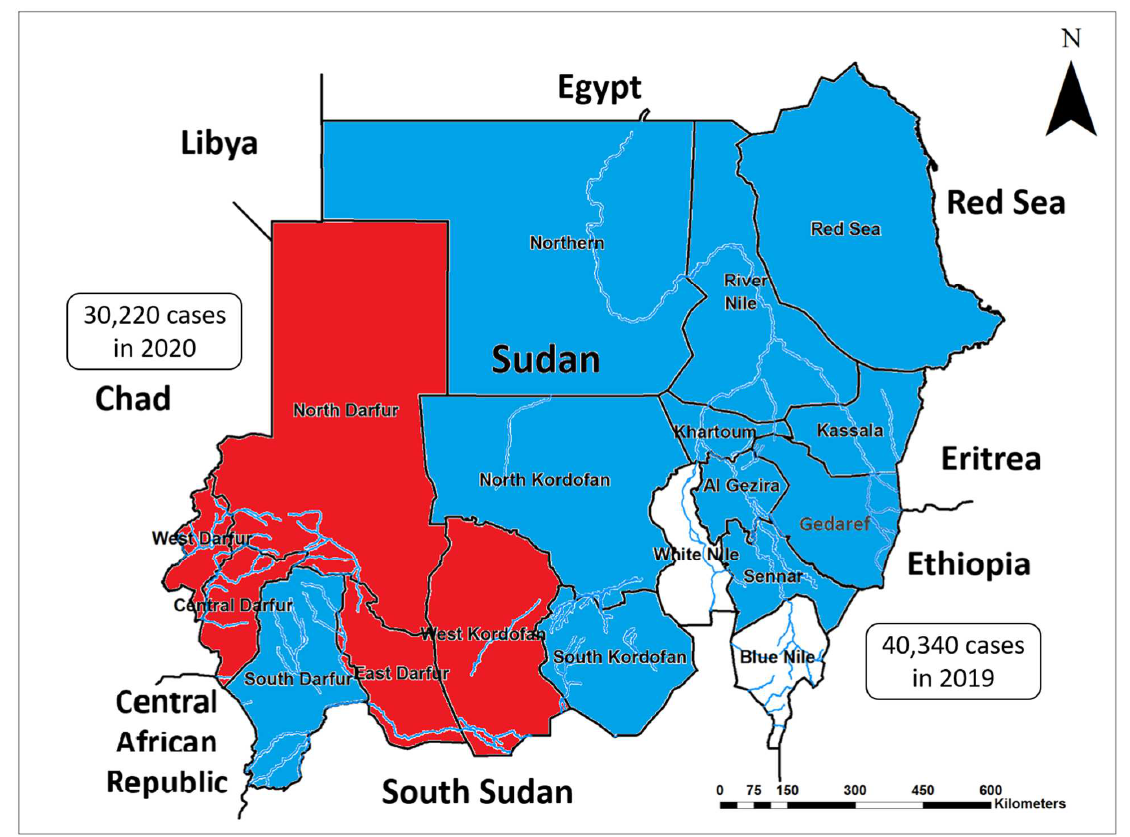
Figure 5. Map of Sudan showing the geographical distribution of chikungunya virus infections before (blue) and after (red) 2020 throughout the country. Up to now, no transmission is reported in the two states without color: White Nile and Blue Nile states. The number of cases reported during two outbreaks in the neighboring countries, Chad and Ethiopia, are included in the textboxes.